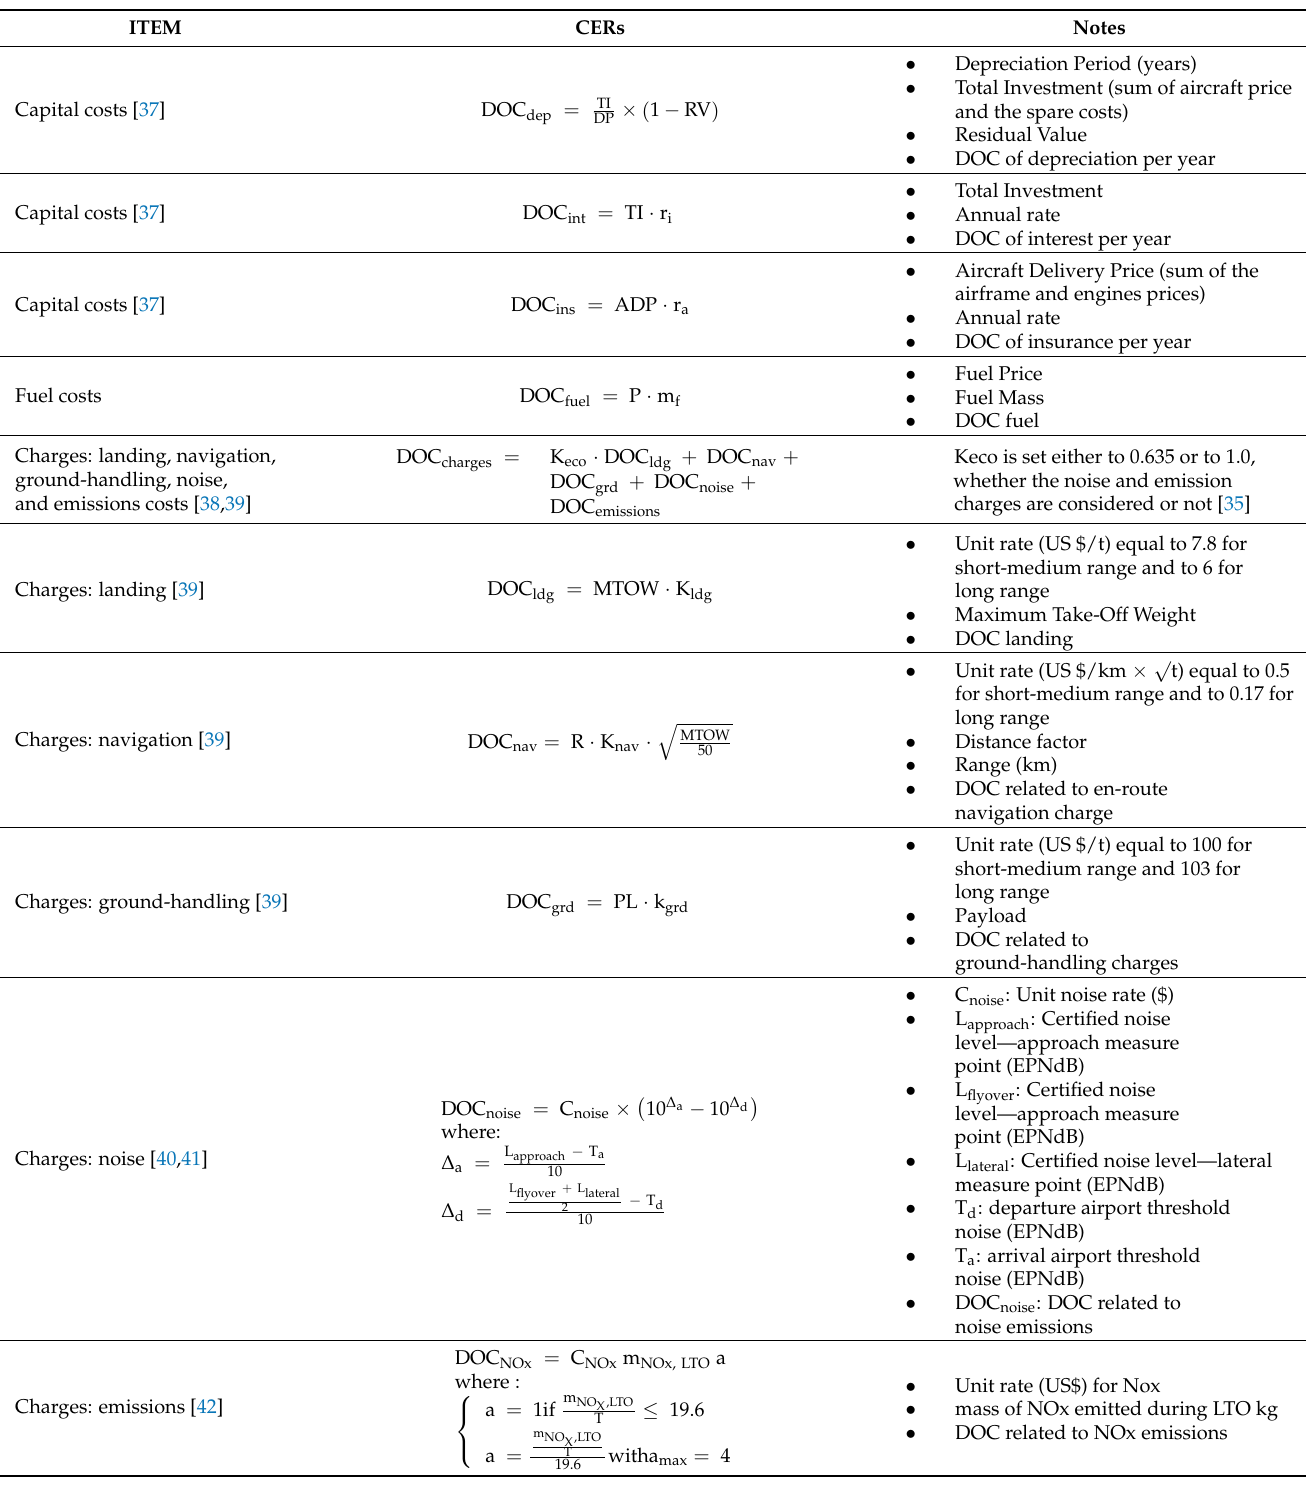
Table 1. Summary of Cost Estimation Relationships for DOC